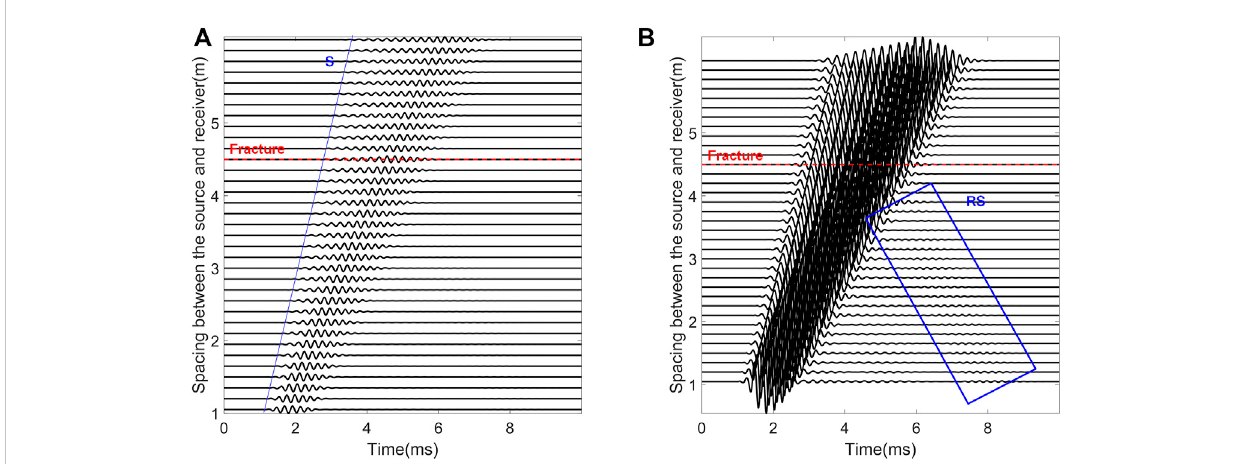
FIGURE 6 Dipolearraywaveforms.The reddotted linestandsfor thefracture center,whichis4.5 mawayfromthesound source. Thefracturedipangle is90 ° , the fracture width is 40 mm and fi lled with calcite. (A) Array waveforms (original); (B) Array waveforms (S wave is ampli fi ed by 10 times).